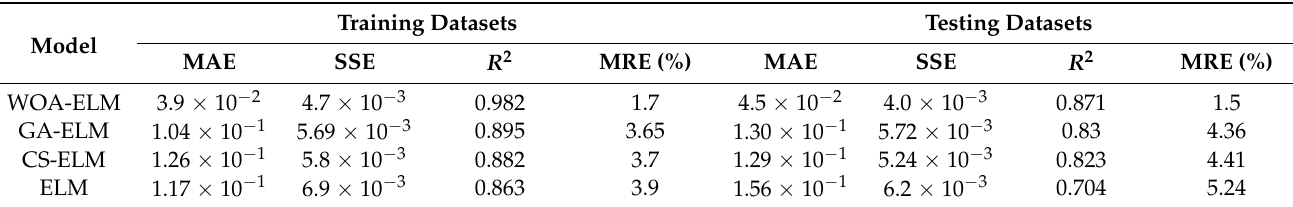
Table 10. Comparison of the performance of WOA-ELM and ELM.